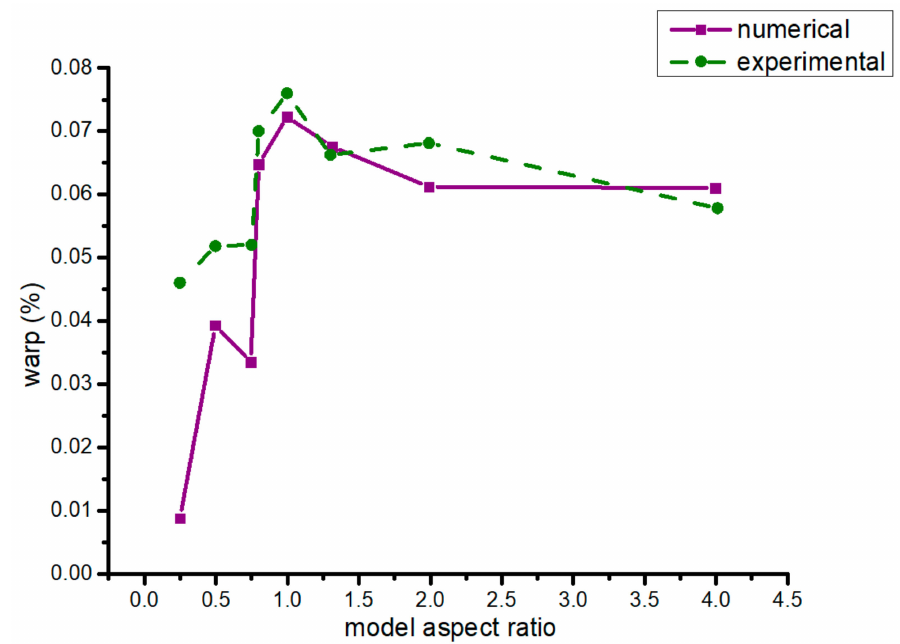
Figure 9. Warp in di ff erent model aspect ratios (numerical and experiment results).